Question: Produce a descriptive caption suitable for publication.
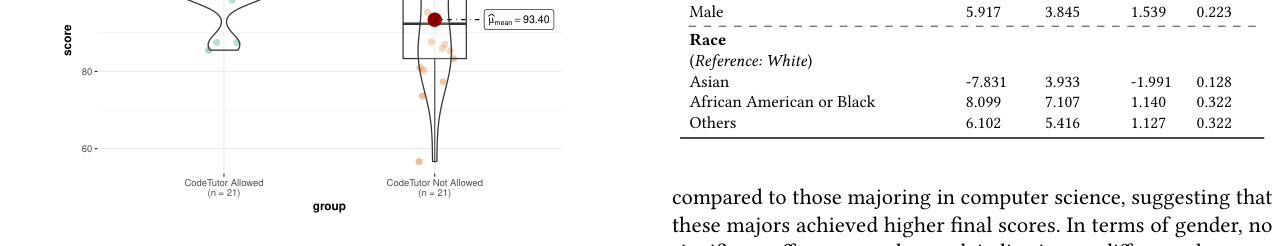
Answer: Parametric pairwise comparison (ANOVA) reveals a significantly higher mean score in the “CodeTutor-Allowed” group compared to the “CodeTutor-Not-Allowed” group.